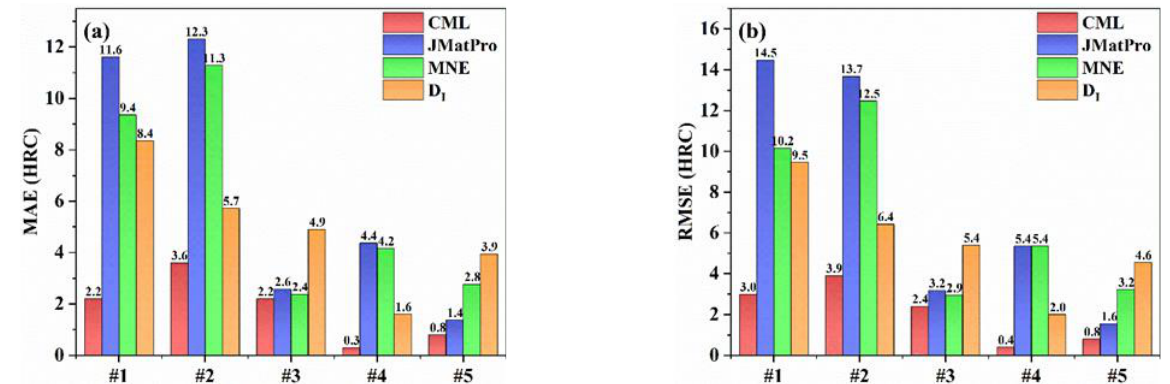
Figure 8. Comparison of the error values calculated by different calculation methods on the test set: ( a ) MAE; ( b ) RMSE.